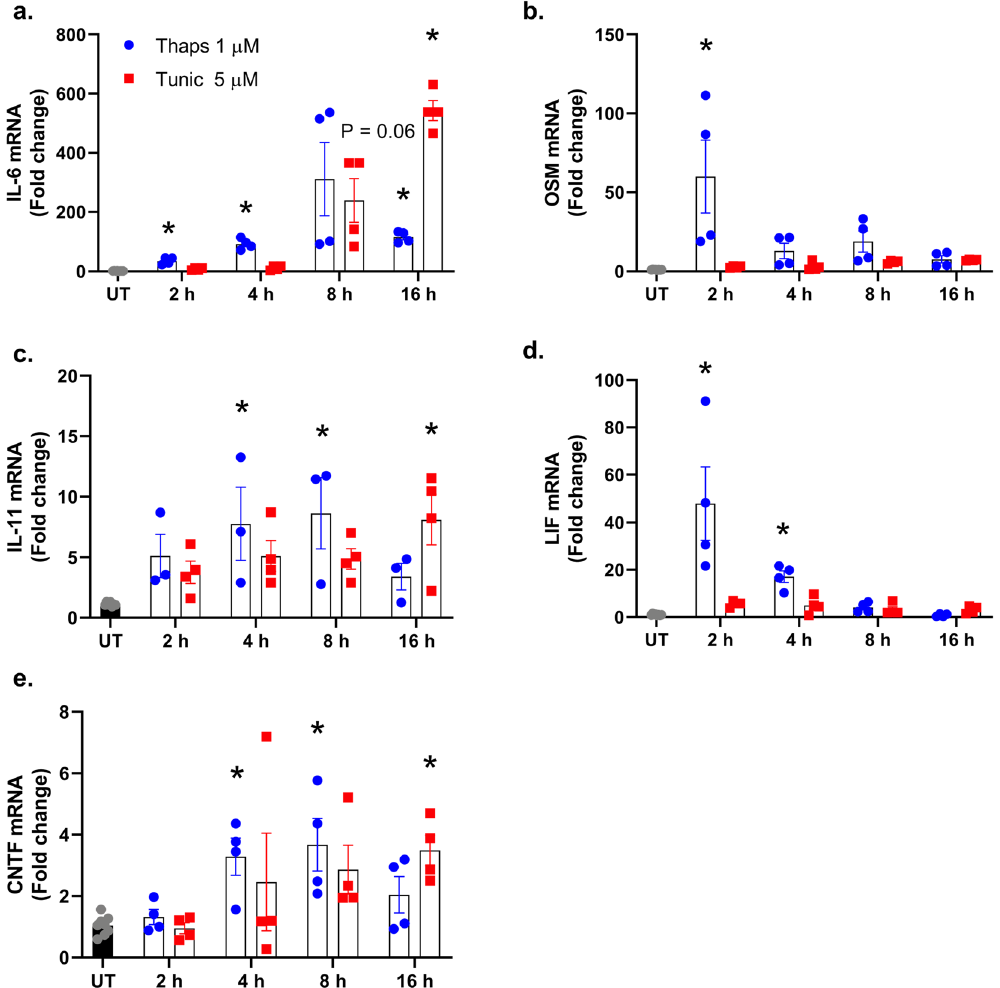
Figure 3. Time-course of the IL-6 cytokine family expression in bone marrow-derived (BMD) macrophages during ER stress. ( a – e ) Wild type BMD macrophages were stimulated with 1 µ M thapsigargin (thaps) or 5 µ M tunicamycin (tunic), and mRNA expression was analyzed by qPCR. N = 4, * P ≤